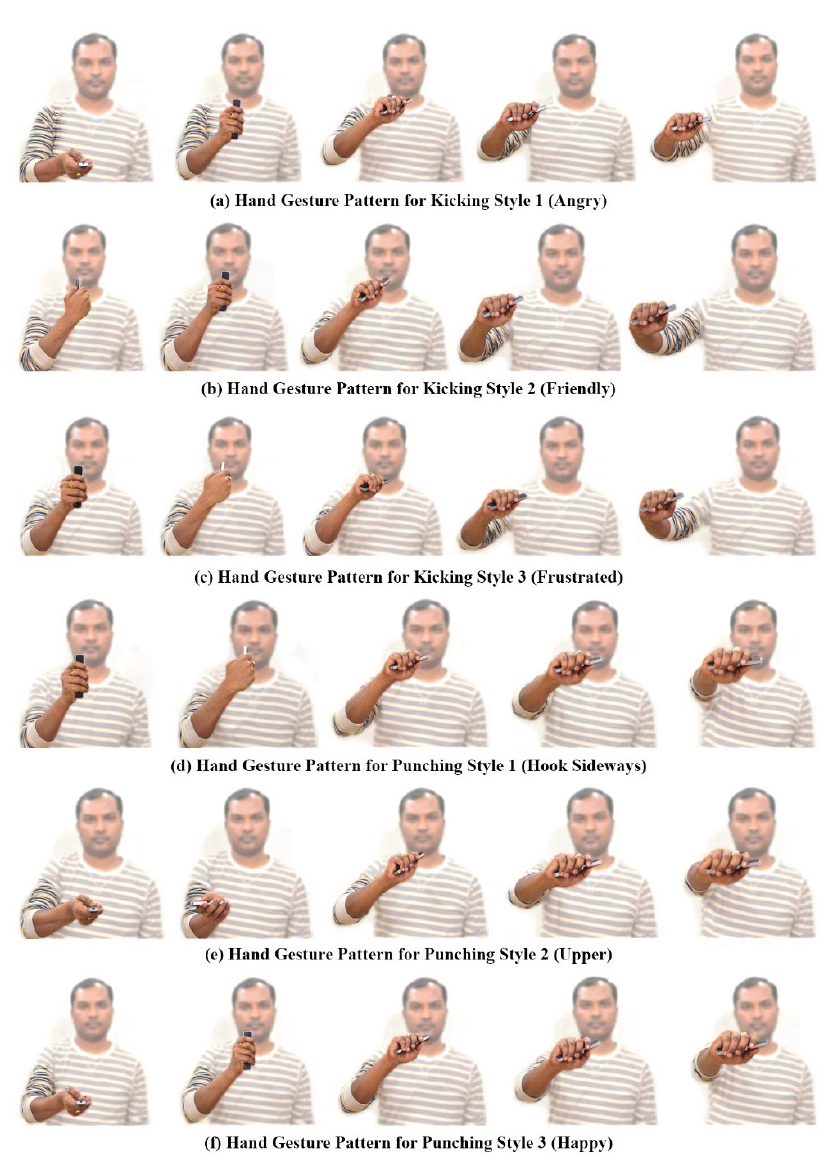
Figure 6. Mimic gesture patterns for kicking and punching